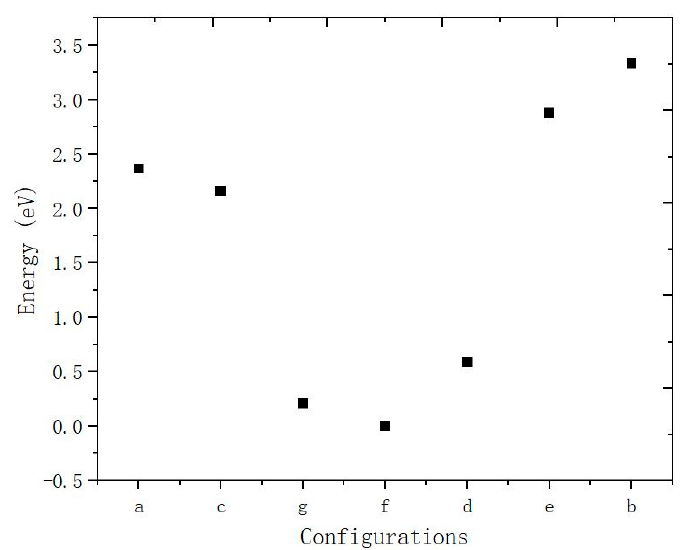
Figure 2. Energy differences across seven water monomer conformations. Structure f is the base- line and has the lowest system electrostatic potential. and has the lowest system electrostatic potential. Table 1. Energy difference (E) and optimized structural parameters of the seven models. The lowest system energy of conformation f was taken as the reference point. The two nearest H–Cl distances are presented for